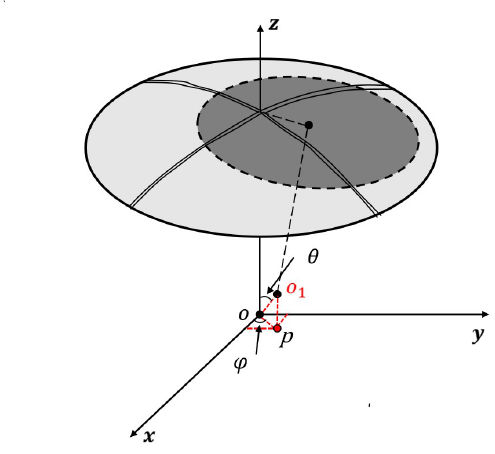
Figure 2. Functional block